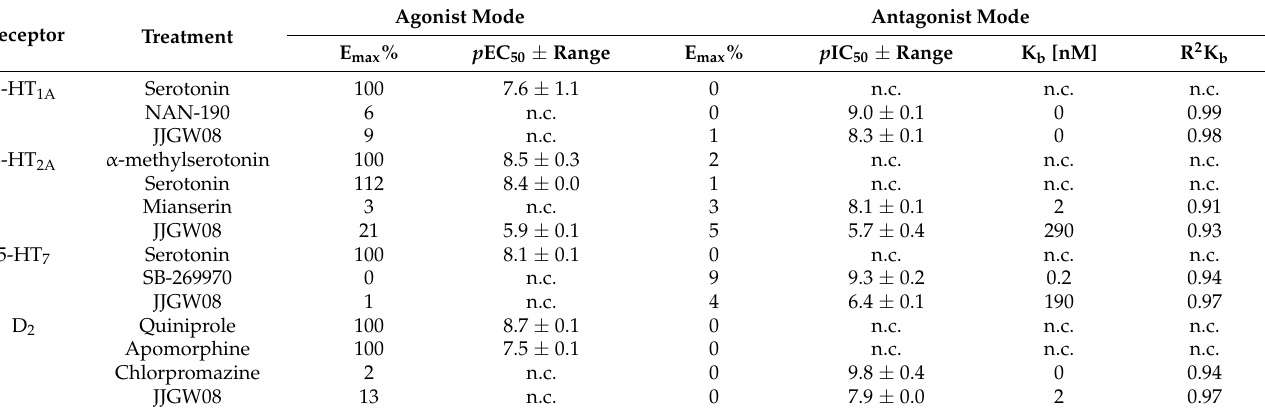
Table 1. The intrinsic activity of JJGW08 for serotonin 5-HT 1A , 5-HT 2A , and 5-HT 7 receptors and dopamine D 2